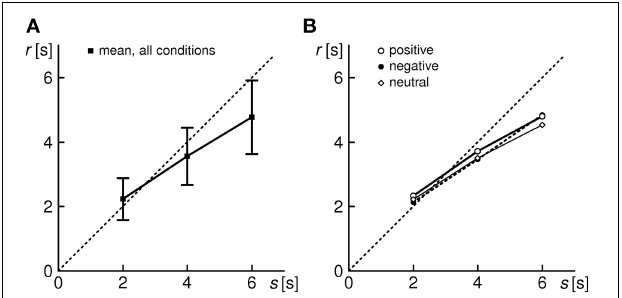
FIGURE 2 | Average reproduction response for the entire sample of 31 subjects. (A) All conditions (shown are grand means ± 1 SD ). (B) Separated by conditions E , N , P ( SD bars omitted for the sake of